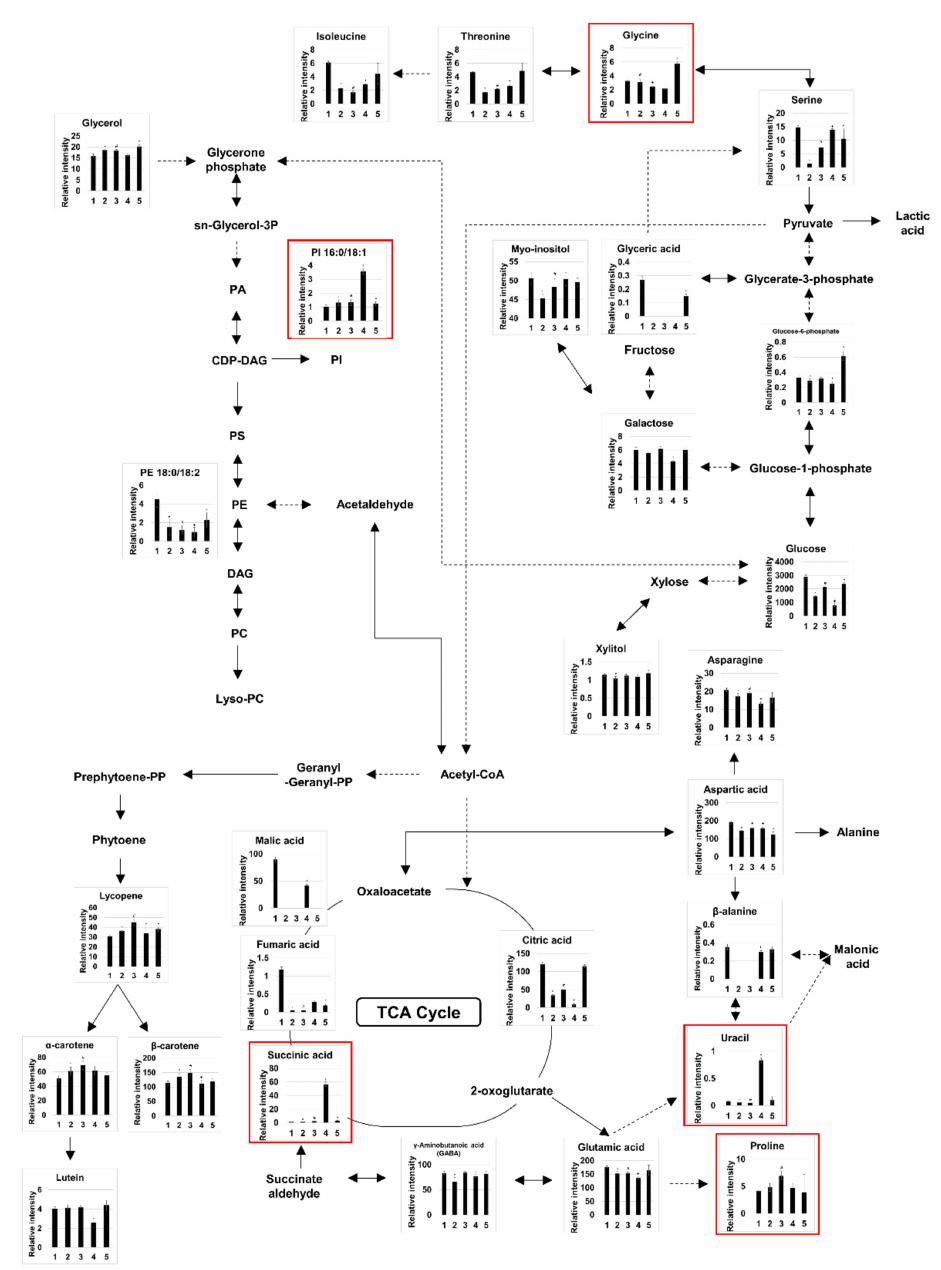
Figure 2. Relative intensity of metabolites, lipids, and carotenoids in the fermented and non-fermented VJs and the related metabolic pathways. Citrate cycle (TCA cycle) and the alanine, aspartate, and glutamate metabolism pathways. Glycine, serine, and threonine metabolism and the glycolysis pathways. Glycerophospholipid metabolism pathway. Carotenoid biosynthetic pathway. Significant differences ( p < 0.05) between fermented VJs and the control (1) are indicated as follows: ({(2) L. plantarum (HY7712), *; (3) L. plantarum (HY7715), #; (4) L. helveticus (HY7801), + ; (5) B. lactis (HY8002), ˆ}, p < 0.05). PC, phosphatidylcholine; PE, phosphatidylethanolamine; PI, phosphatidylinositol; PS, phosphatidylserine; PA, phosphatidic acid; DAG, diacylglycerol; CDP-DAG, cytidine diphosphate-diacylglycerol. The major differential compounds (4 metabolites and 1 intact lipid) between the fermented and non-fermented VJs are shown in